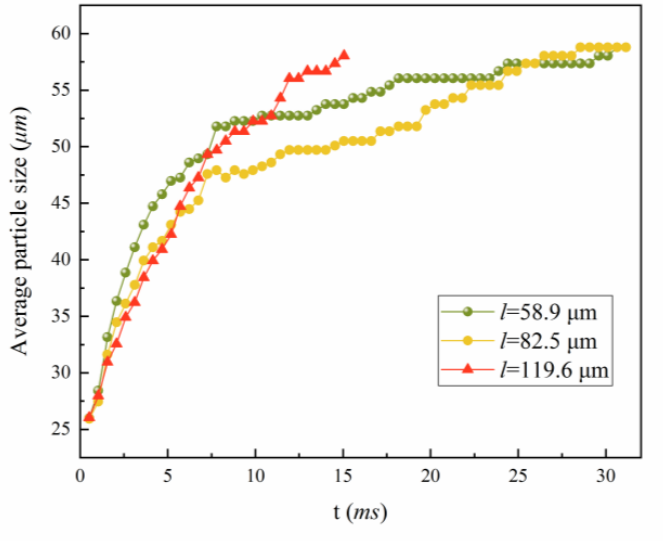
Figure 3. Calculated average particle sizes with different fluid grids, where l is the width of the fluid grid.